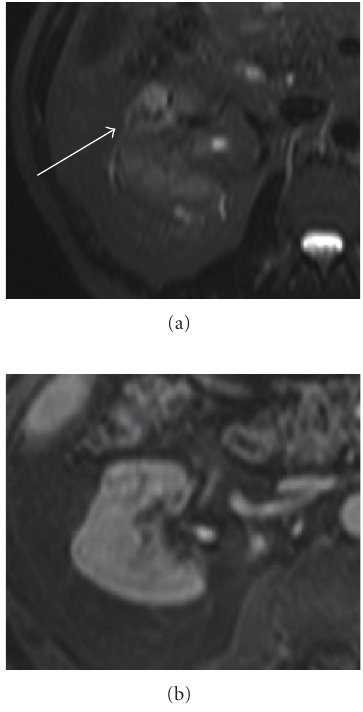
Figure 13: (a) Axial stir and (b) axial postcontrast T1. A pseudocapsule is seen as a hypointense rim surrounding the tumor on T2 and is better delineated than on postcontrast T1 owing to the late contrast enhancement of the